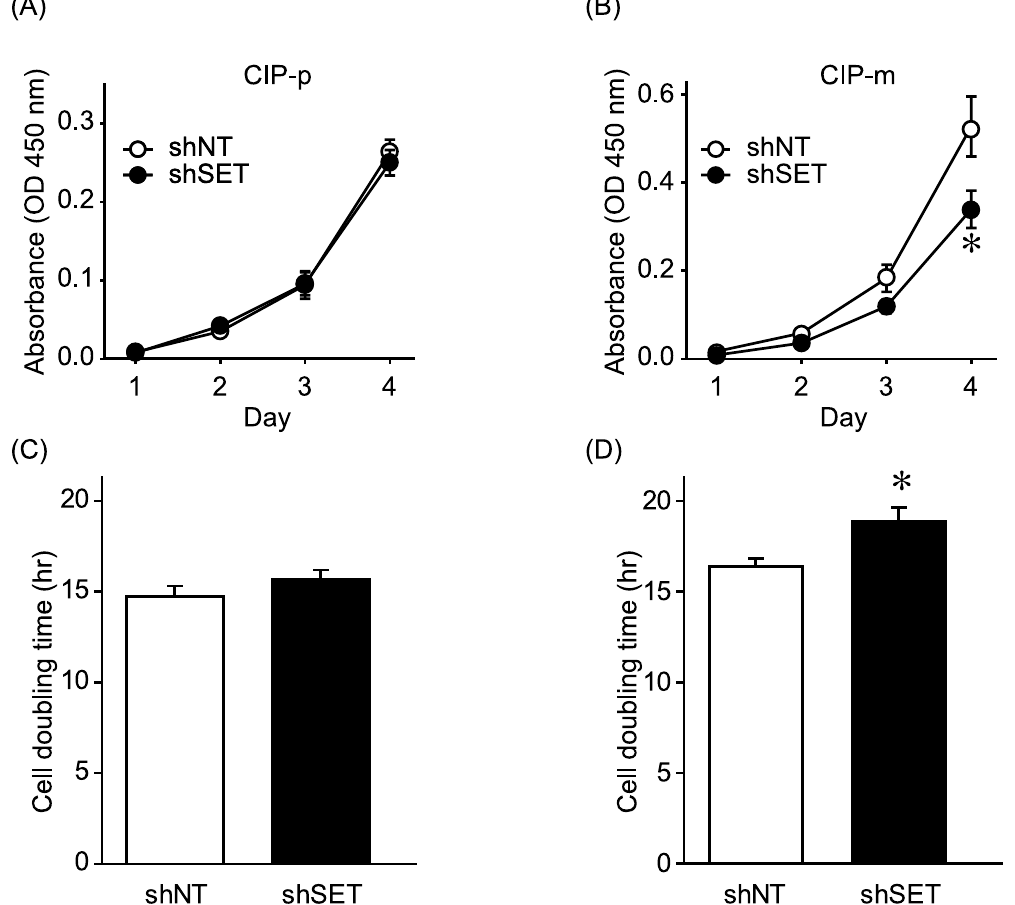
Figure 2. SET knockdown suppressed proliferation of canine mammary tumor cells. ( A and B ) Cell proliferation of CIP-p ( A ) and CIP-m ( B ) expressing shNT or shSET was determined by Cell Counting Kit-8. Quantitative data from 3 independent experiments performed duplicate are shown. * P < 0.05 vs. shNT. ( C and D ) Cell doubling time of CIP-p ( A ) and CIP-m ( B ) expressing shNT or shSET was determined as described in Material and Methods. 15–17 cells from 2 independent experiments were analyzed. * P < 0.05 vs.